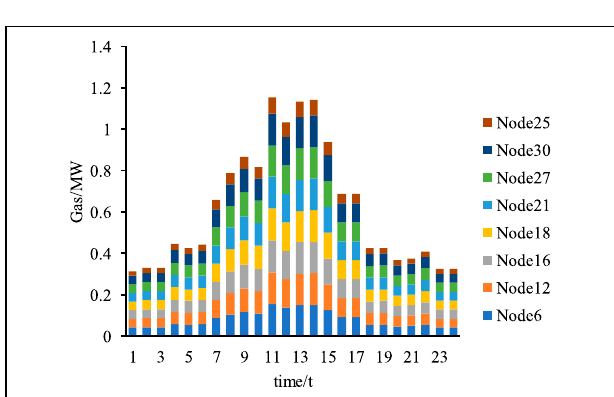
FIGURE 9 | Hourly total purchase of natural gas.